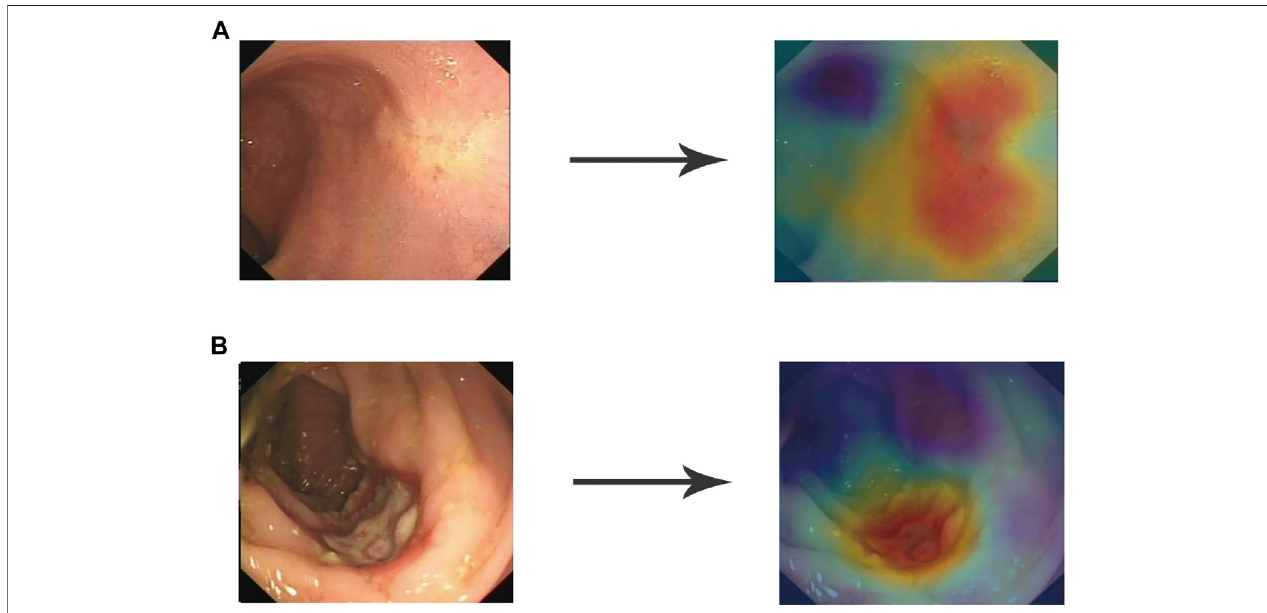
FIGURE2| HeatmaptovisualizetheDCNNmodel.Theheatmapismainlycomposedofredtonesandbluetones.Theredtonesrevealtheveryregionoftheinput image that activates the category (TRG0 or non-TRG0), which is what we are interested in, while the blue tones are the regions of non-interest. The darker the red tone, the more important the region. (A) Representative image of TRG0. (B) Representative image of non-TRG0. DCNN, deep convolutional neural network.